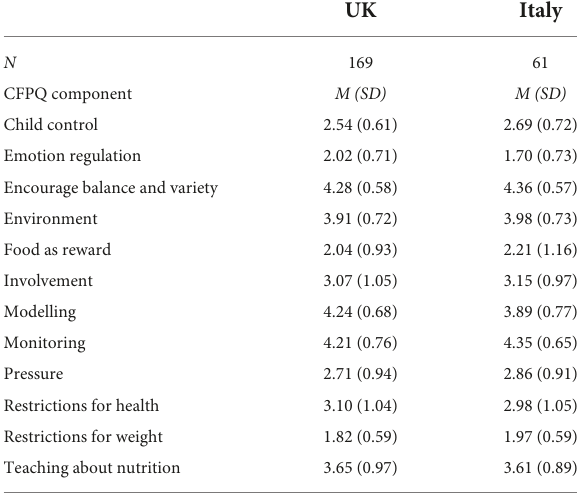
TABLE 4 Comprehensive feeding practices questionnaire component scores for parents in the UK and